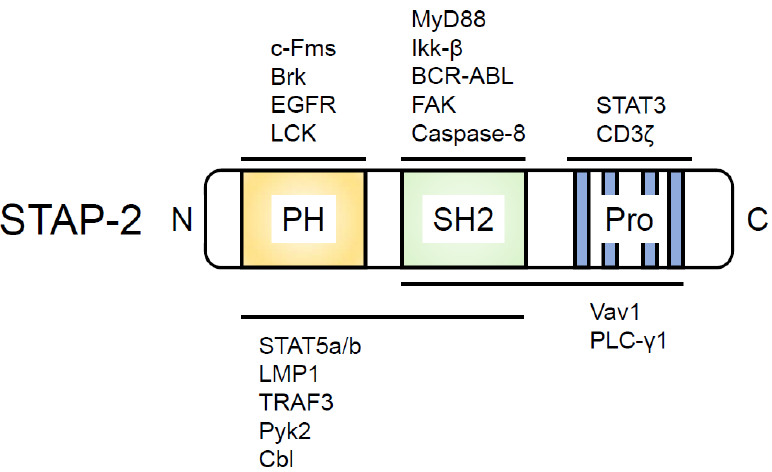
Figure 1. STAP-2 structure and domain-binding proteins. PH, Pleckstrin homology domain; SH2, Src homology 2 (SH2) domain; Pro, Proline-rich region containing a YXXQ motif. The proteins that